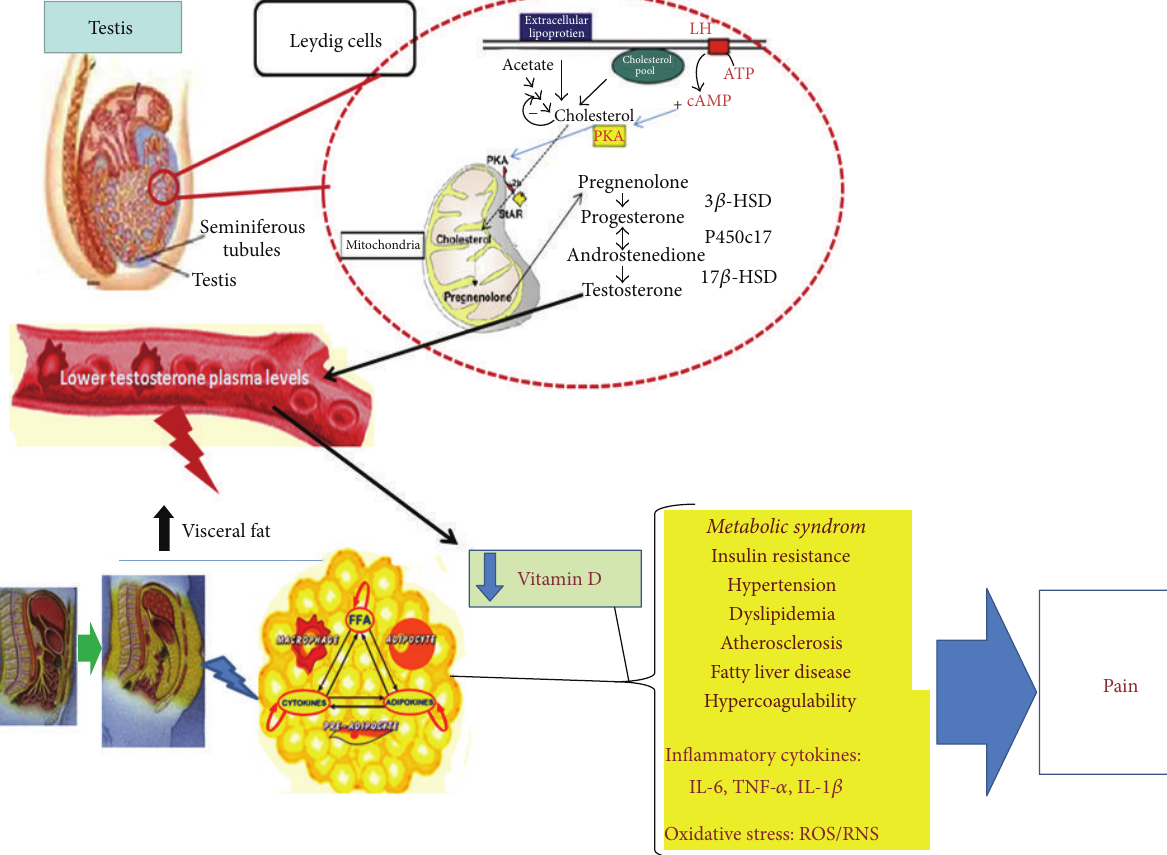
Figure 1: Representative schema of the clinical consequences suggested to be related to androgen deficiency. Lower testosterone levels are associated with an increased metabolic risk, systemic inflammation, and chronic